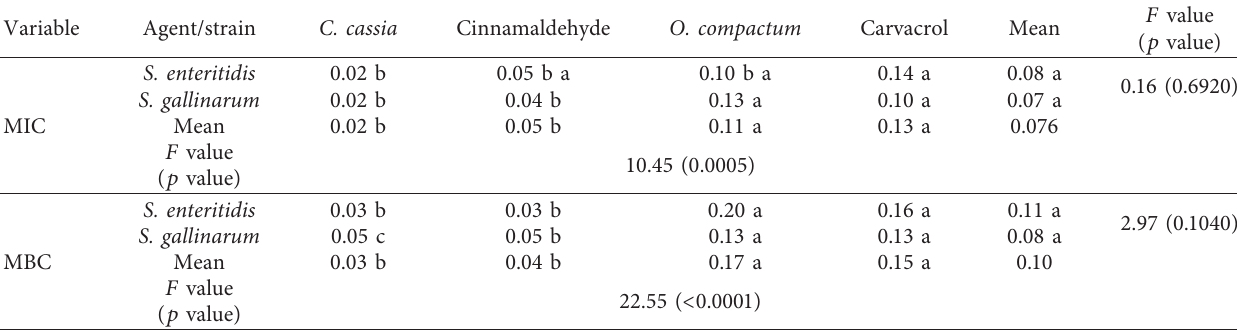
Table 5: Minimum inhibitory concentrations (MIC) and minimum bactericidal concentration (MBC) (%) (v/v) means of the essential oils tested and their majority compounds according to the Salmonella